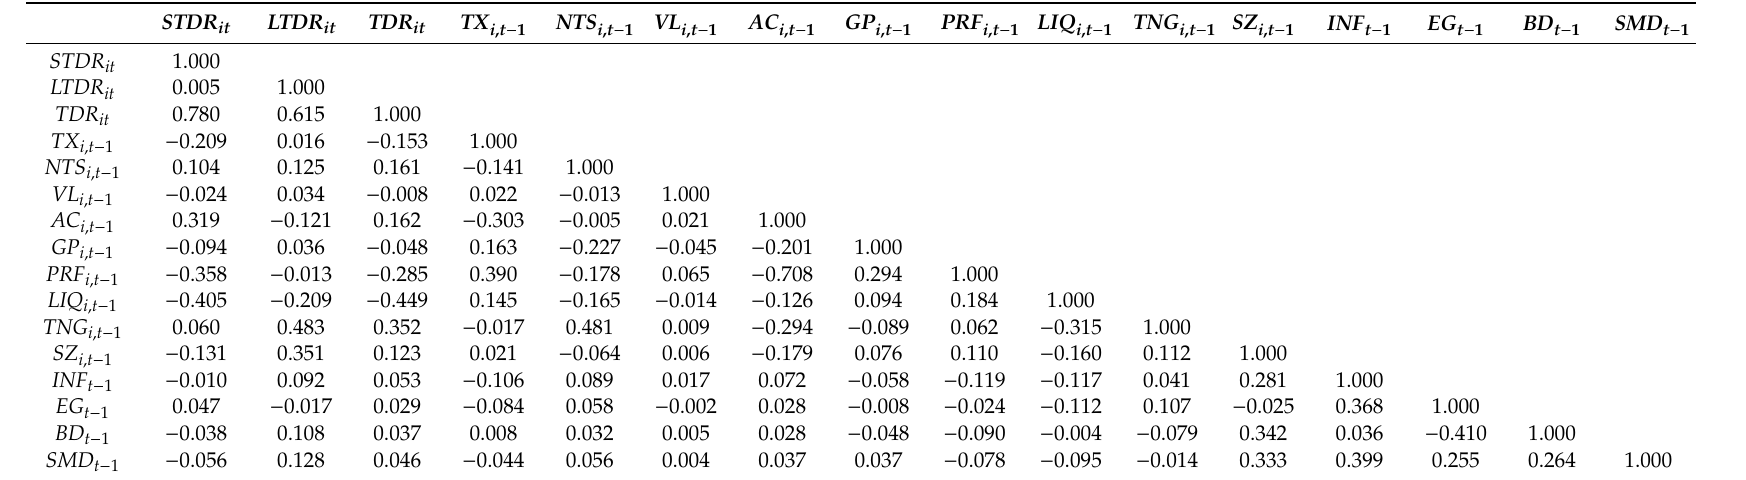
Table 5. Pair-wise Correlation (Moderately Competitive